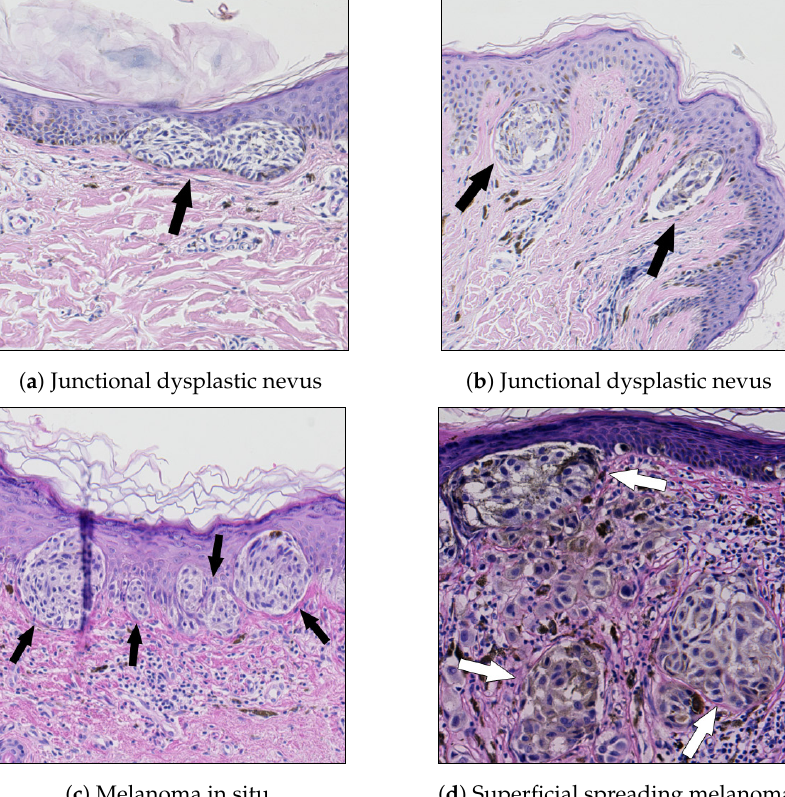
Figure 2. Examples of melanocytic lesions containing nests of nevus cells: ( a ) in junctional dysplastic nevi, nevus cells are typically arranged in cohesive nests along the dermal-epidermal junction nests and often join together; ( b ) in nevi, nests are often positioned at the tips of rete ridges; ( c ) in melanoma in situ, there are often large, confluent nests, irregular in shape and size, unevenly distributed along the dermal-epidermal junction; and ( d ) in SSM, nests are present above the suprapapillary